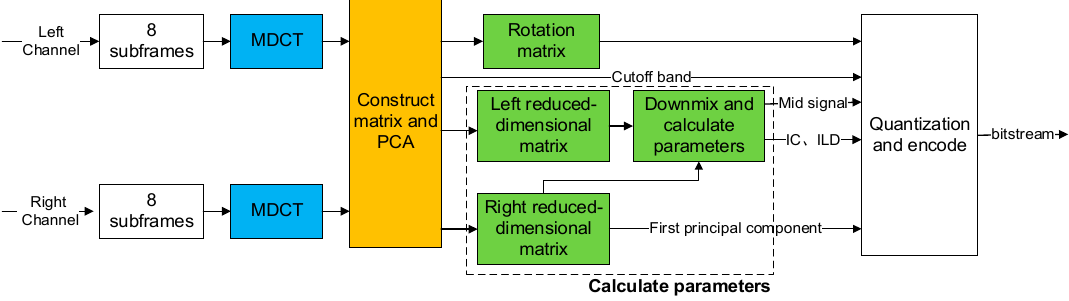
Figure 12. Flowchart of stereo encoder. (MDCT, Modified Discrete Cosine Transform; PCA, Principle Component Analysis; IC, Interaural Coherence; ILD, Interaural Level Difference).